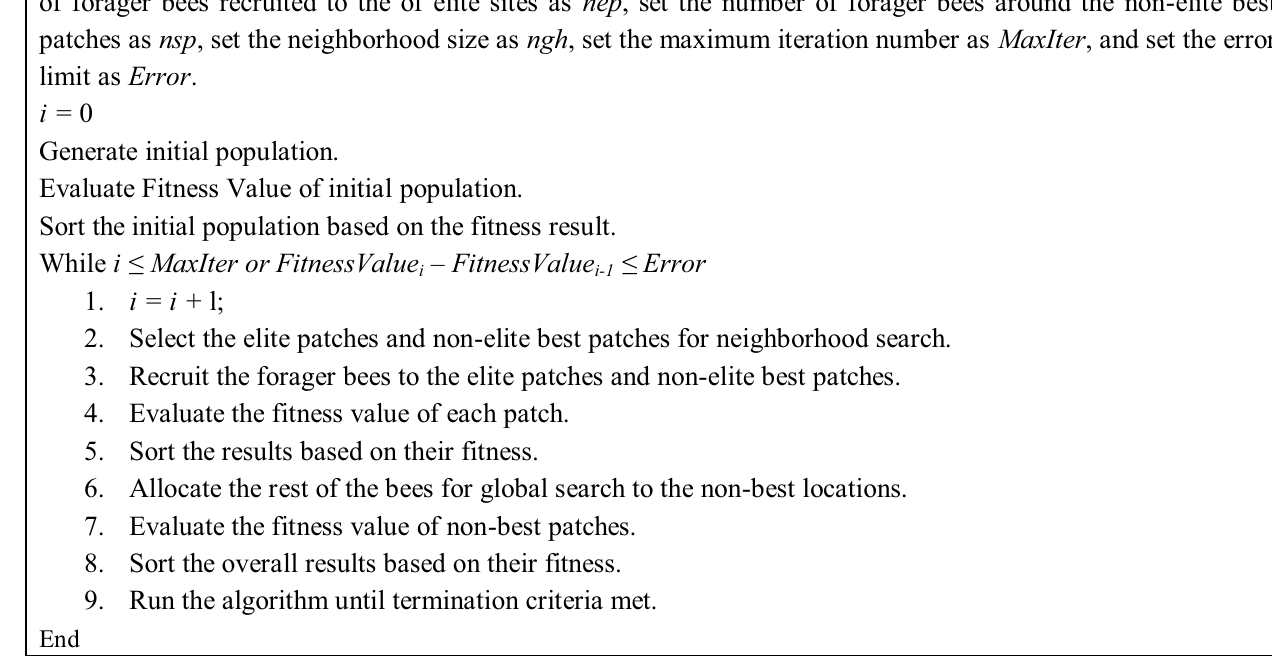
Figure 2. Pseudo-code of the basic Bees